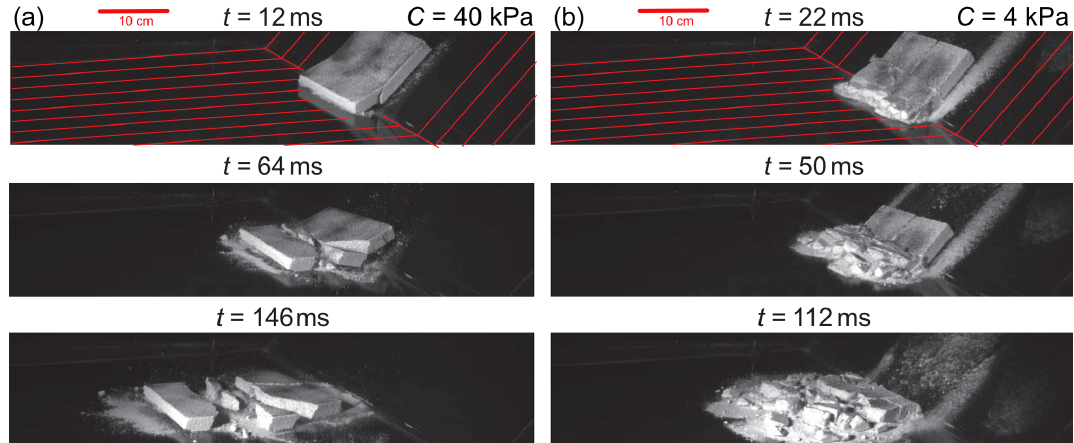
Figure 2. Snapshots from the experiments showing an (a) intermediate-strength sample ( C = 40kPa) and a (b) low-strength sample ( C = 4kPa).The red lines in the upper images indicate the geometry of the basal plates. Images are chosen to represent similar travel distances in (a) and (b) . The time given above each image reflects the time since the first impact. The samples have dimensions 15 × 15 × 2cm. Note that the stronger sample (a) breaks apart into six large fragments with a limited amount of fine material produced and moves apart with little interaction after breaking. In contrast, the weaker sample (b) fragments into many small pieces with a large fraction of fine material causing frictional interaction and that deposits relatively early. Movies of the experiments are available in Haug et al.